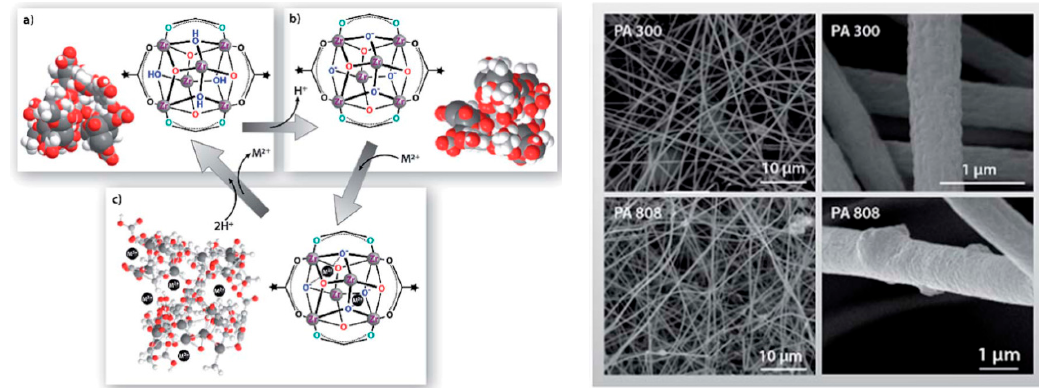
Figure 6. (Left) Electrostatic adsorption between MOF 808 and heavy metals at the surface and pore space caused by a change in pH. ( a ) MOF 808, ( b ) deprotonated MOF 808, and ( c ) heavy metal ion bound MOF. M 2 + refers to heavy metal ions; black dots represent adsorbed M 2 + . Color code: Zr = grey, C = ash, O = red, H = white. (Right) SEM images of the nanofibrous membranes with 20 wt% MOF loading: PA 300 and PA 808 (Reproduced with permission from [38]. Copyright The Royal Society of Chemistry, 2018).